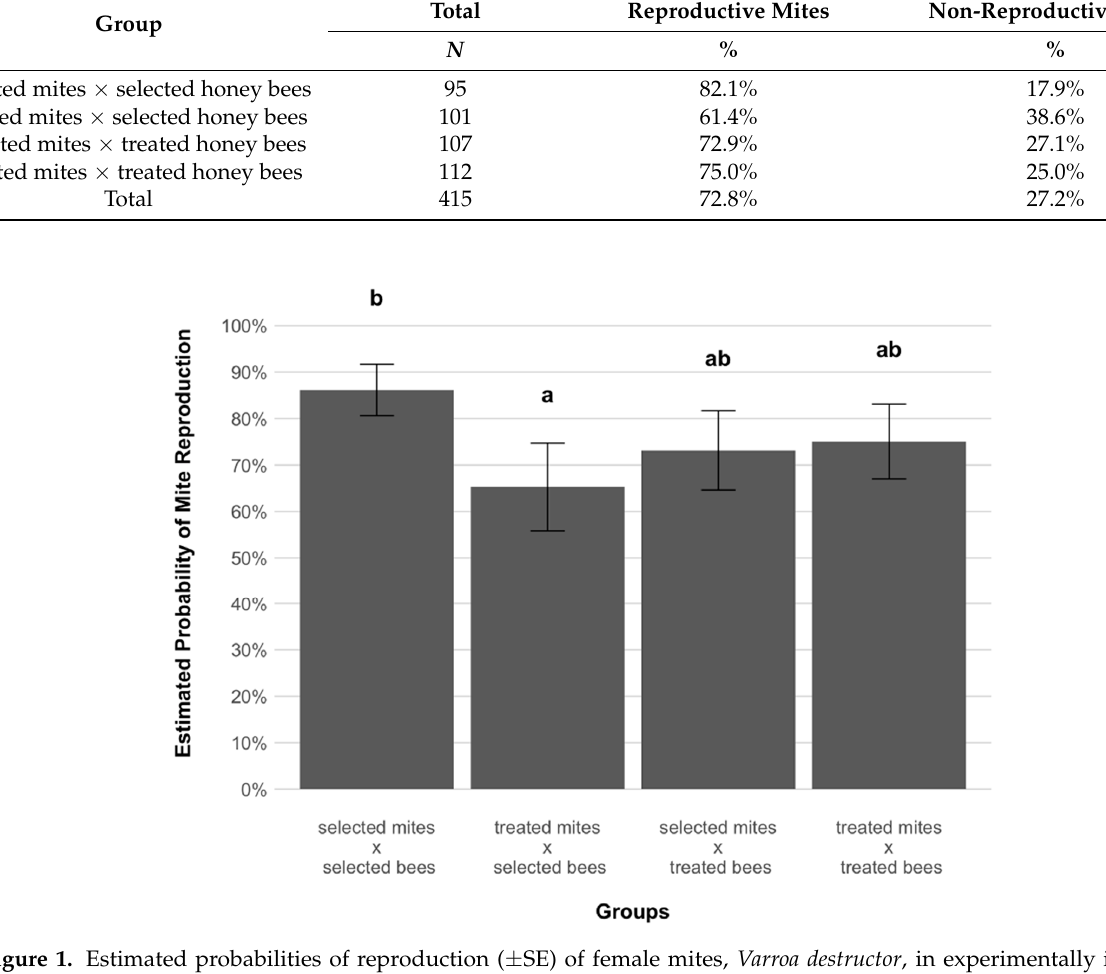
Table 2. Reproductive status of female foundress mites, Varroa destructor , from selected or treated honey bee, Apis mellifera , host colonies in association with experimentally infested worker brood cells of either selected or treated host colonies in the fully-crossed field experiment (selected-selected, treated-selected, selected-treated, treated-treated, respectively). The total numbers of mites as well as the number ( N ) and proportions (%) of reproductive and non-reproductive mites are shown.